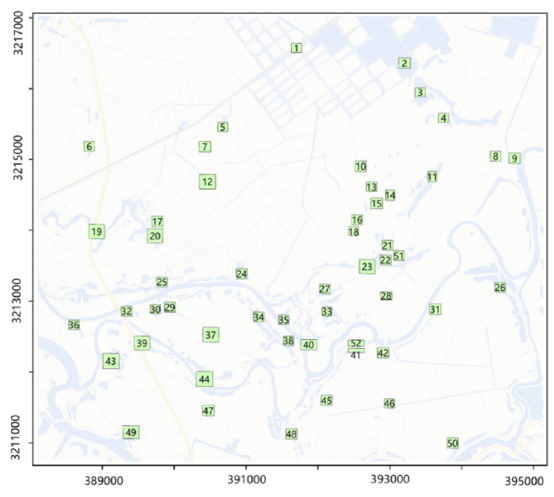
Figure 3. Spatial distribution of the tasks. The UAV swarm comprised five UAVs. The flight speed of the UAV was 15 m/s, endurance time was 1 h, the maximum flight range of the UAV was 36 km, and the maximum flight range of the UAV swarm was 180 km. The networking communication system adopted the TD-LTE scheme, as shown in Figure 4.